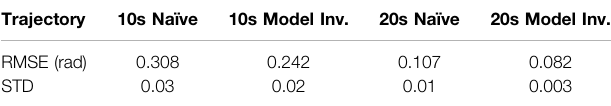
TABLE 3 | Mean RMSE and STD of trajectory error. Trajectory 10s Naïve 10s Model Inv. 20s Naïve 20s Model Inv. RMSE (rad) 0.308 0.242 0.107 0.082 STD 0.03 0.02 0.01